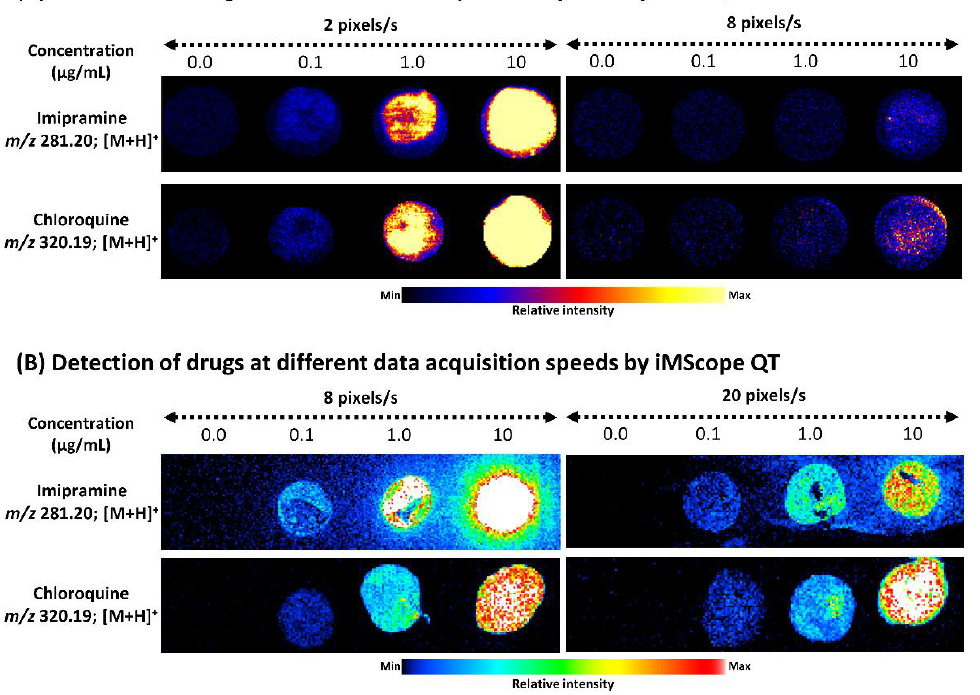
Figure 1. Ion images of imipramine and chloroquine detected by DESI-QTOF and iMScope QT. ( A ) Effects of data acquisition speed on the detection limit of DESI-QTOF for imipramine and chloroquine. ( B ) Effects of data acquisition speed on the detection limit of iMScope QT for imipramine and chloroquine. For DESI-QTOF, 0.3 µL solutions of both drugs were applied on a standard glass slide, and for iMScope QT, 0.3 µL solutions of both drugs were applied to the mice brain section. s: second.